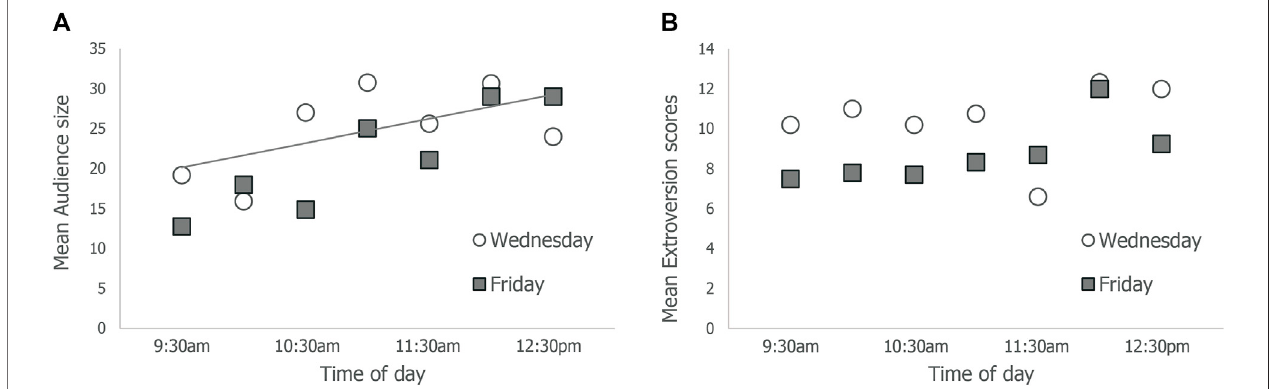
FIGURE 12 | Mean audience size (A) and Extroversion scores (B) plotted over 30-min intervals on both testing days.